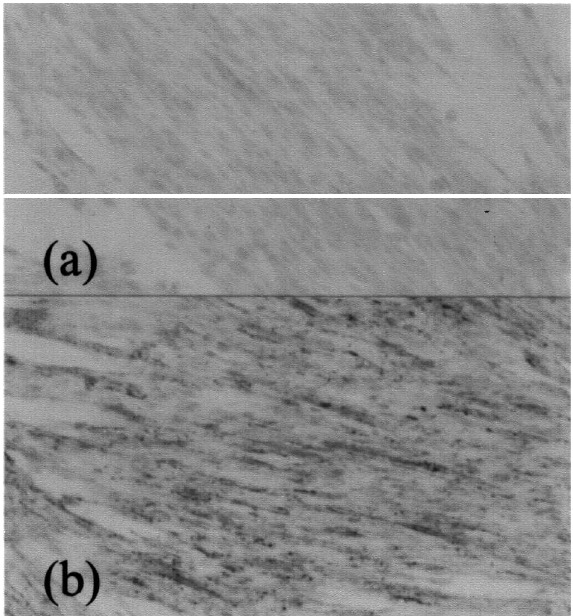
FIG. 3. APAAP stains for ICAM-1 on human fibroblasts treated with medium alone (A) or TNF- a (B) ( ´ 100). Human fibroblasts expressed ICAM-1, showing a weak diffuse positivity on their surface. ICAM-1 expression on the surface of human fibro- blasts increased after stimulation with TNF- a